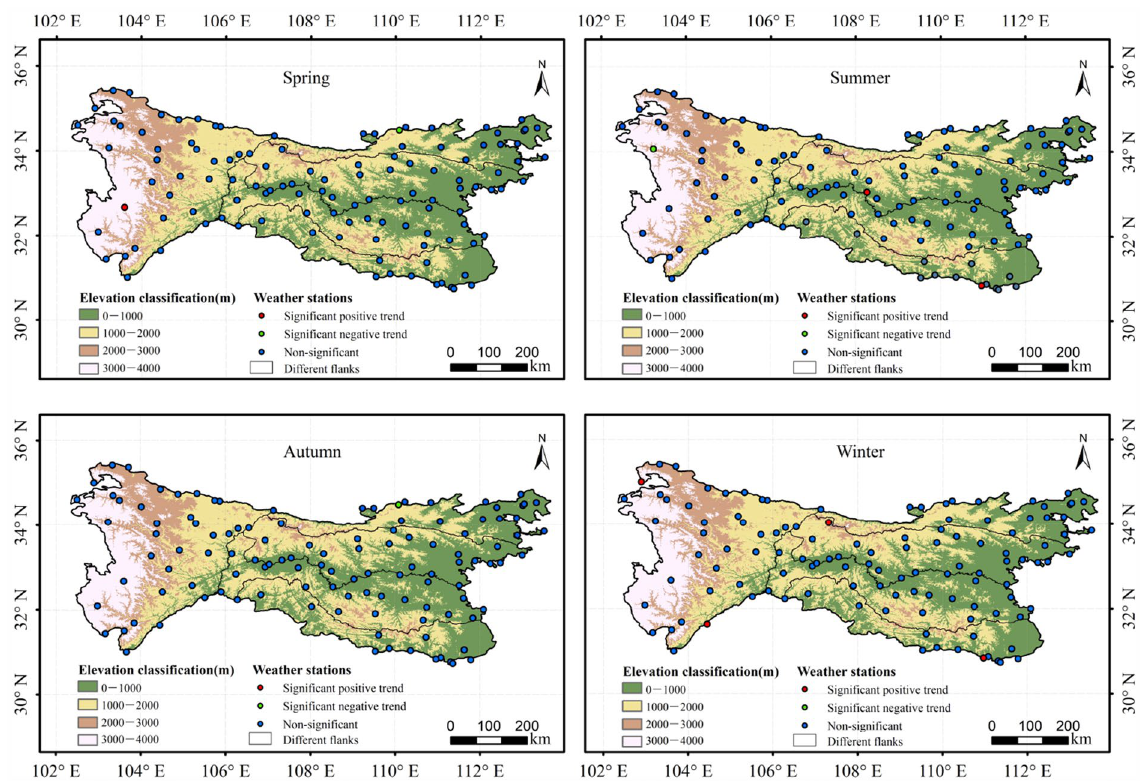
Figure 6. Significance analysis of precipitation changes for different weather stations based on the Mann– Kendall tests at the 5% significance level at different elevations, on different flanks, and in different seasons in the Qinling–Daba mountains during 1969–2018.